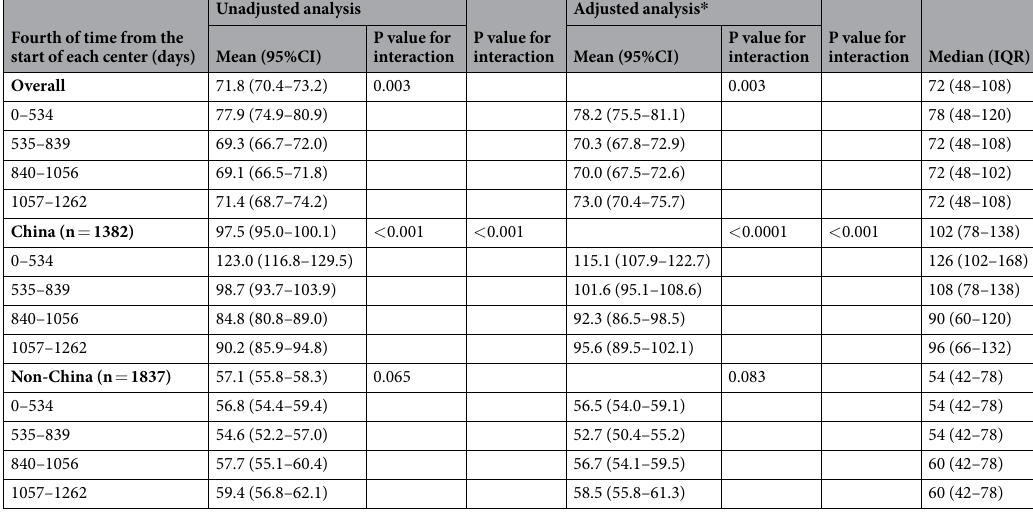
Table 2. Door-to-Needle time over time. CI denotes confidence interval; IQR denotes InterQuartile Range. * Adjusted for time from onset to hospital arrival, sex, baseline diastolic blood pressure, Off-hour admission (night time, weekend, and public holidays), No. of patients treated in the center, and CT or MRI angiogram showing proximal